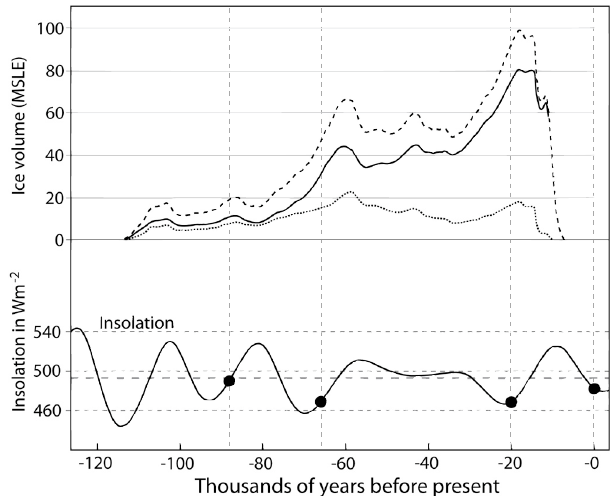
Figure 1. Evolution of the Northern Hemisphere ice volume and variations in daily average top of the atmosphere insolation during the northern summer solstice (60 ◦ N) as a function of time. The solid and dotted lines in the top panel show the volume of the North American and Eurasian ice sheets, respectively and the dashed line is the total ice volume. The black dots in the lower panel mark the relative time of the simulations and the thick dashed line shows the mean insolation over the time